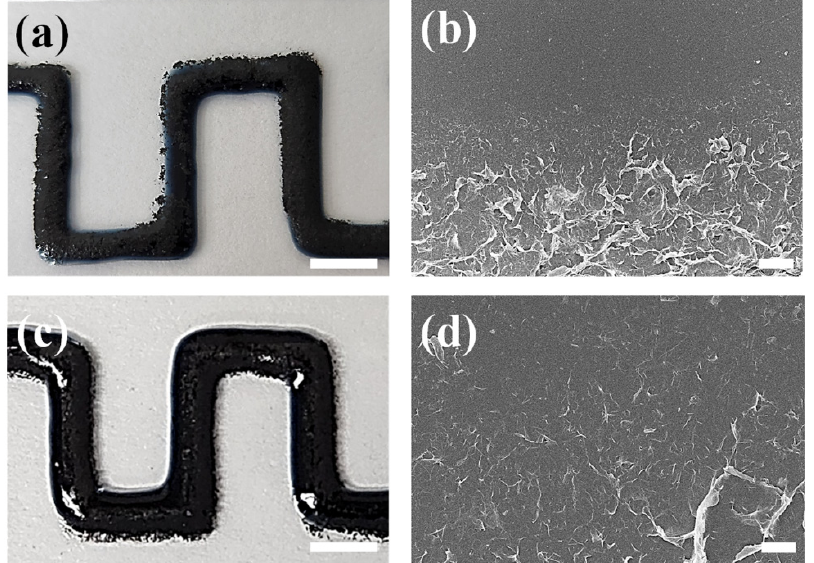
Figure 5. Photo and SEM images of consecutive ink written-PEDOT:PSS/EEG electrodes on the glass substrate. The time interval of 5 min ( a , b ), and several seconds ( c,d ). Scale bars: 5 mm ( a , c ) and 50 μ m ( b , d ).